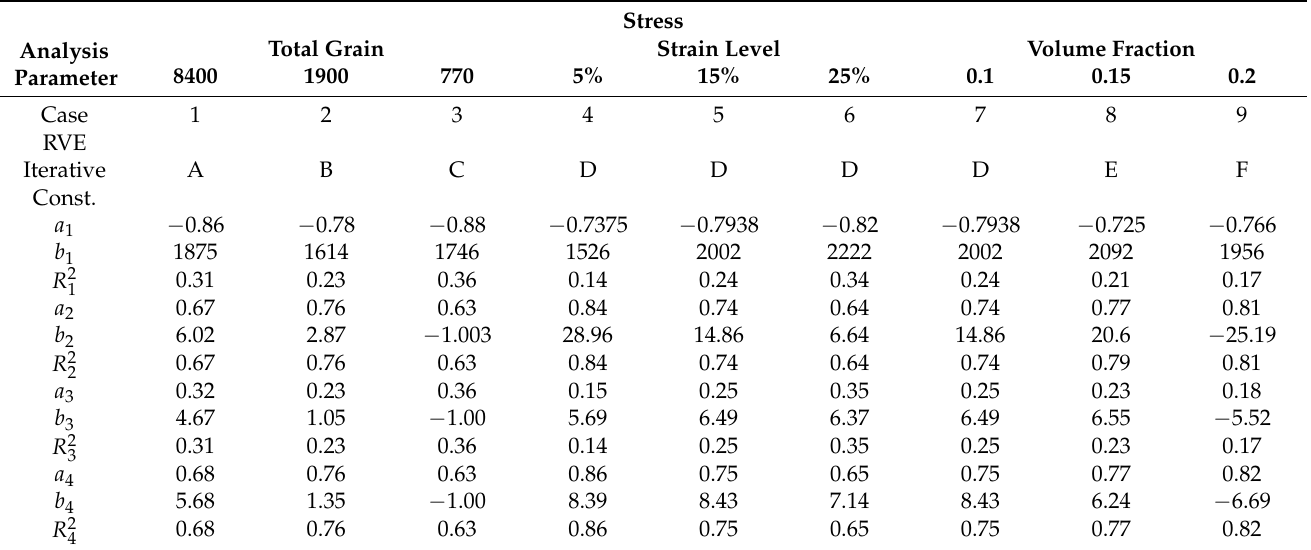
Table A1. Constants a m , b m , and R 2 m (m = 1, 2, 3, 4) for the martensite phase of linear equation with stress condition by the proposed iterative method.